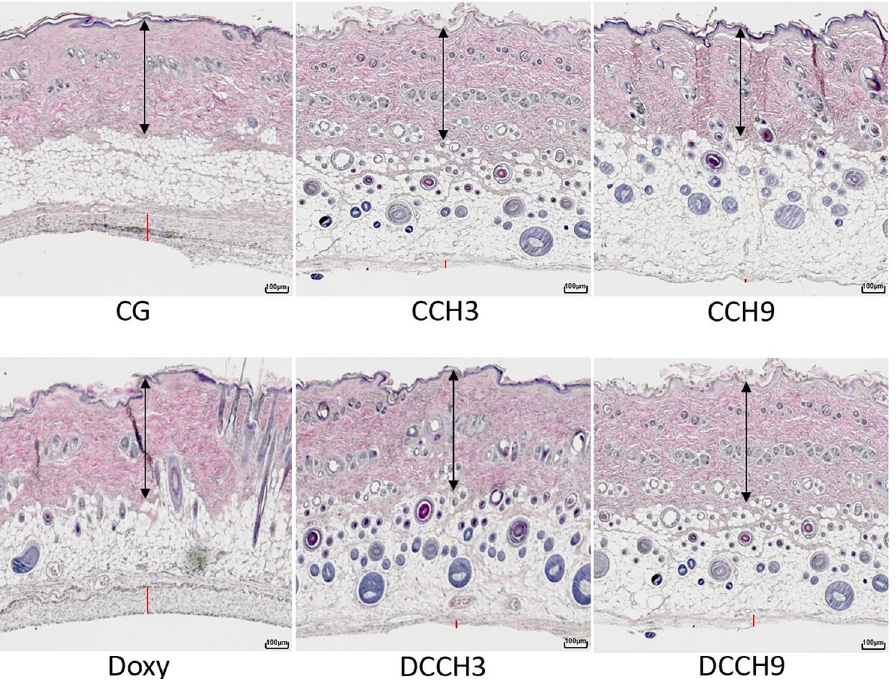
Fig 7. Example pictures of H&E staining of in-vivo study groups. Slides at 40x magnification with arrows indicating skin thickness and red lines indicating capsule thickness. Group size: n = 12.